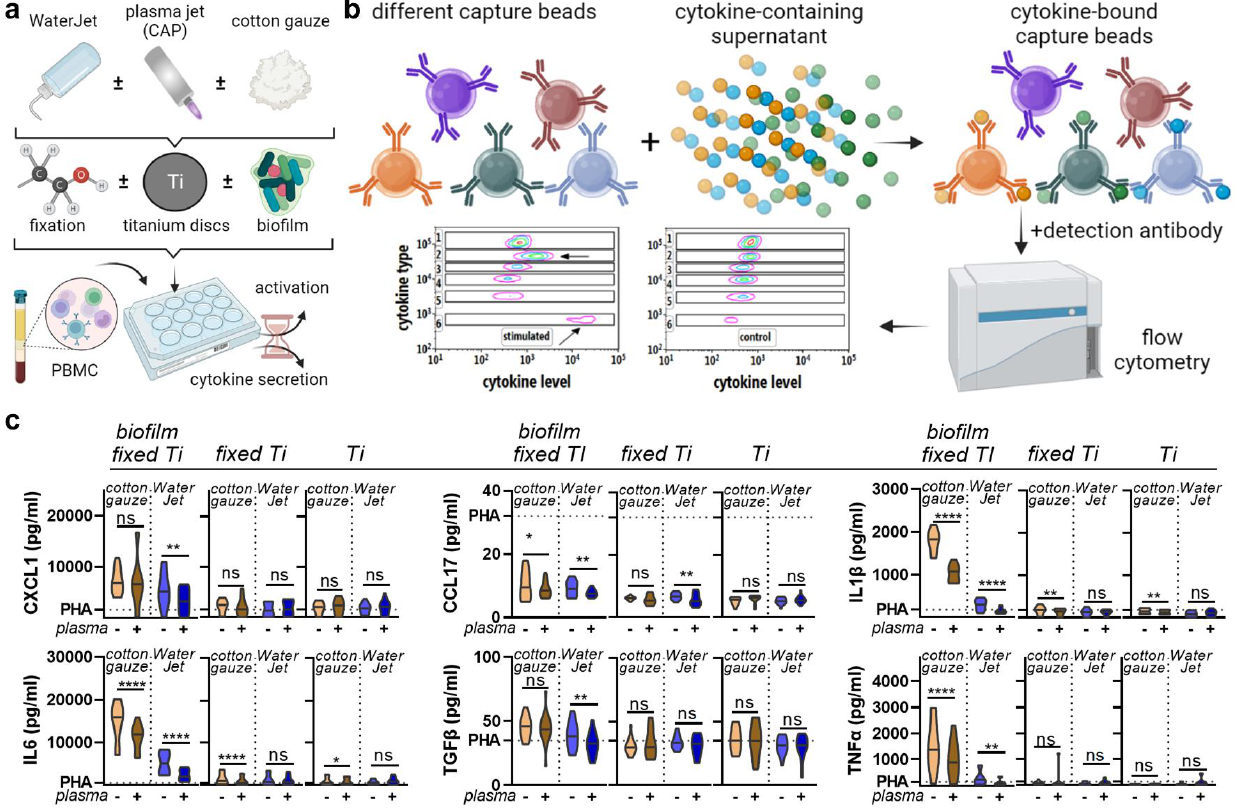
Figure 3. Chemokine and cytokine analysis. ( a ) sampling scheme; ( b ) overview of multiplex assay used in this study; ( c ) absolute analyte concentrations across cotton gauze and WaterJet ± CAP conditions and PHA (dotted line) as reference of leukocyte culture supernatants incubated with contaminated titanium discs (biofilm fixed TI), clean titanium discs exposed to fixative only (fixed Ti), and titanium discs only (no fixation). Principal component analysis across treatments and titanium disc conditions. Data are from four donors and show violin plots and median ( c ). Statistical analysis was performed using paired t -test; * = p < 0.05, ** = p < 0.01, **** = p < 0.0001, ns = not significant. PBMC from four different donors were tested. Biofilm was generated from subgingival plaque of a single periodontally diseased